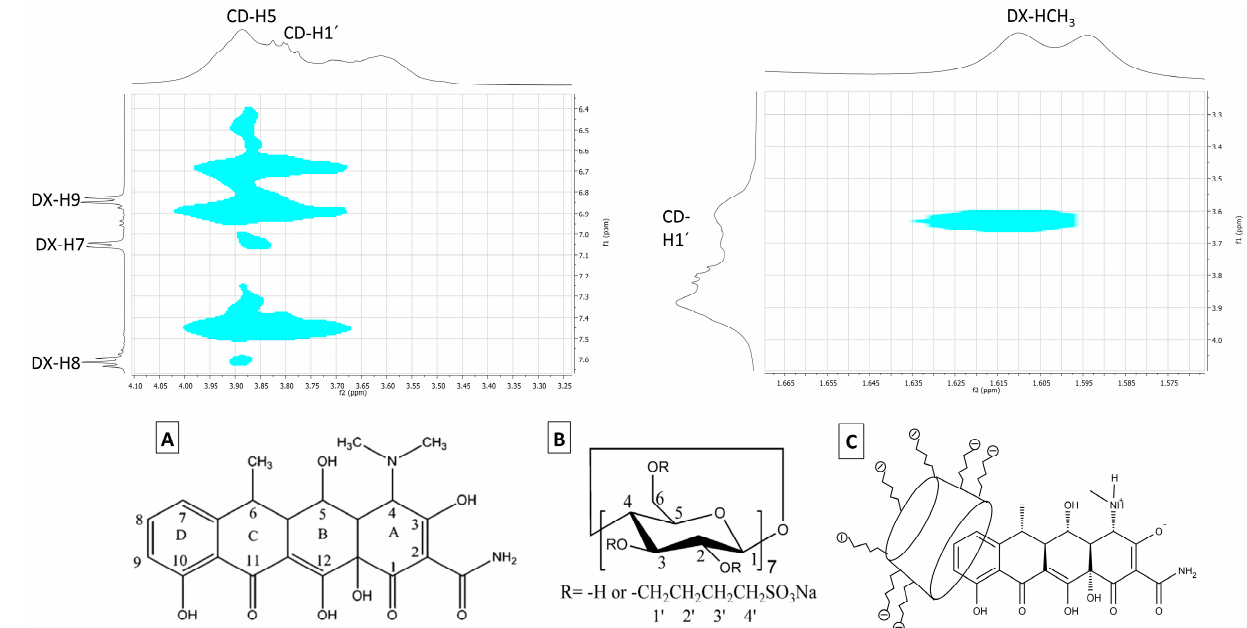
Figure 2. Top : contour plot of the 2D-NOESY spectra of DX/SBE- β -CD inclusion complex. DX: doxycycline. CD: sulfobutylether- β -cyclodextrin (SBE- β -CD). Bottom : ( A ) Molecular structure of doxycycline. ( B ) Molecular structure of SBE- β -CD. ( C ) Proposed geometric arrangement for the DX/SBE- β -CD inclusion complex.